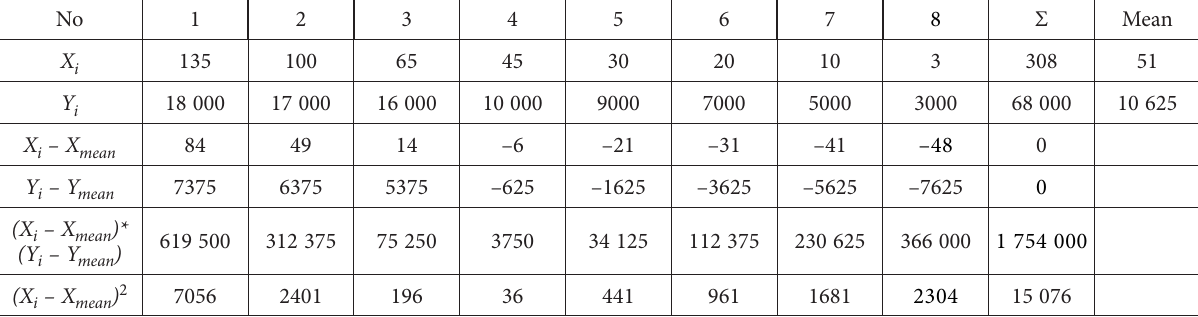
Table 2. Estimation of linear regression parameters by least squares